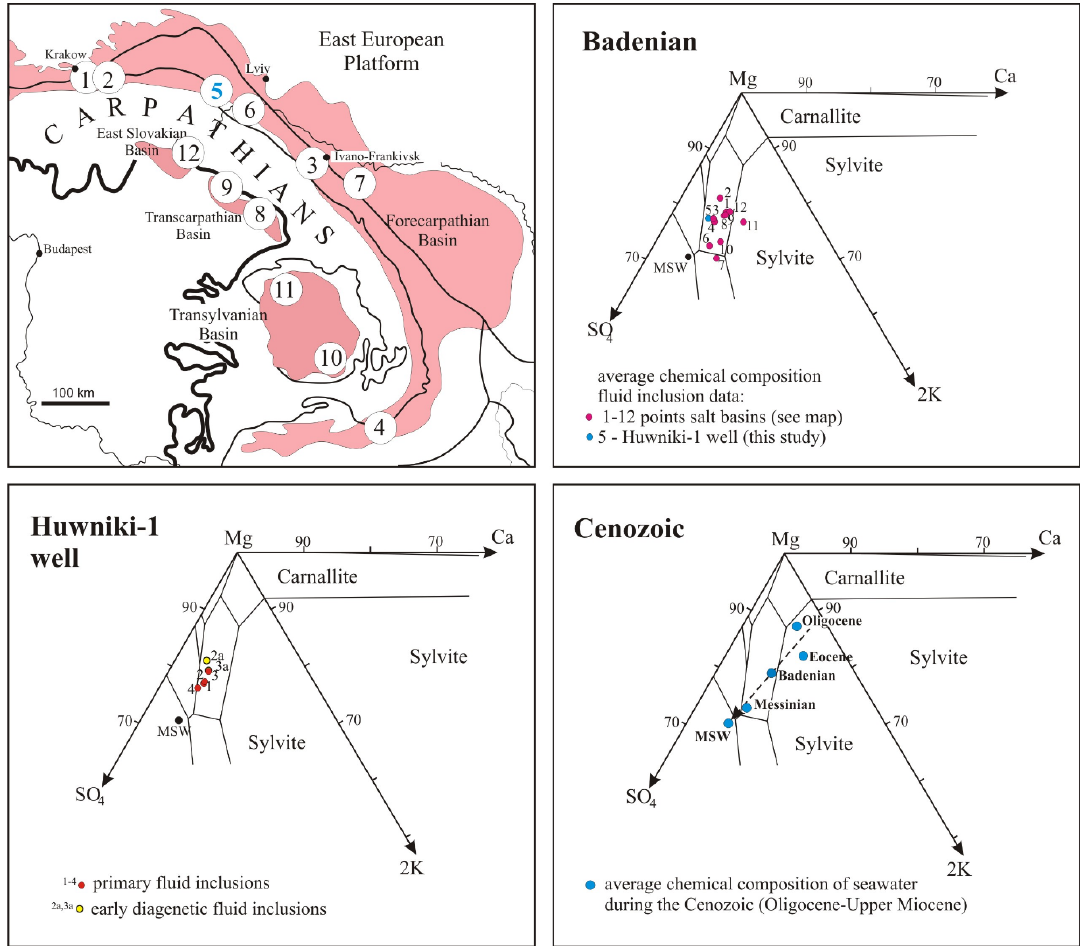
Figure 7. Brine composition in the primary fluid inclusions of chevron halite (mol %), plotted on the Jänecke diagram, at 25 °C, after [54]. The numbers and data mean the following on the map: 1—